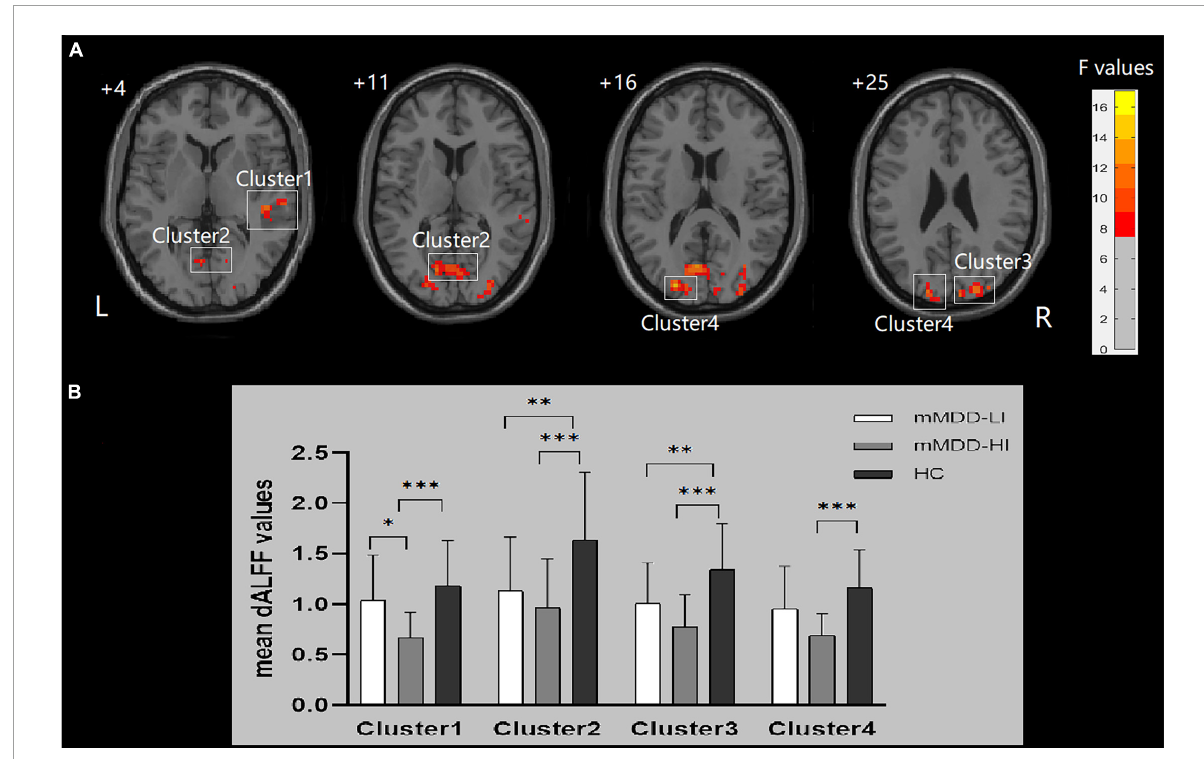
FIGURE1 Differences in dALFF values and post hoc analysis of dALFF values among three groups. Cluster 1: right MTG/STG, Cluster 2: bilateral lingual gyrus/calcarine; Cluster 3: right middle occipital gyrus/superior occipital gyrus/cuneus; Cluster 4: left middle occipital gyrus/superior occipital gyrus/cuneus. (A) Significant difference in dALFF values among the three groups. Significant at p < 0.001 after GRF correction. R, right side; L, left side. (B) Post hoc analysis of dALFF values with significant variations across the three groups. *** p < 0.001 level, ** p < 0.01 level, * p < 0.05 level, Bonferroni